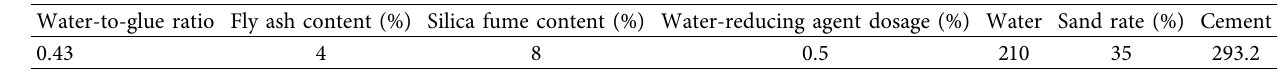
Table 9: Design of the optimal mixing proportion of LPCSHTHSC.